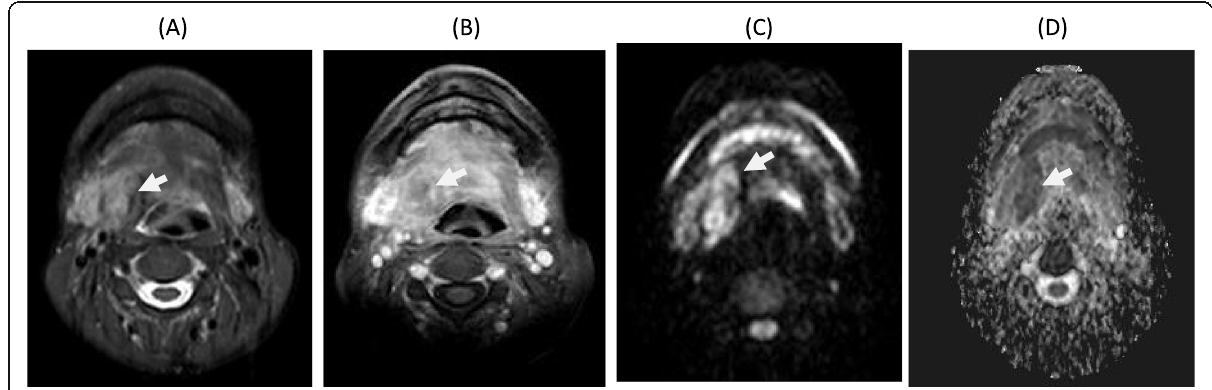
Fig. 1 Pathologically proven recurrent squamous cell carcinoma of the tongue following surgical resection and adjuvant radiotherapy. a Axial fat- saturated T2-weighted image (T2WI) showing an ill-defined lesion of intermediate-to-high signal intensity at the operative bed (right side of